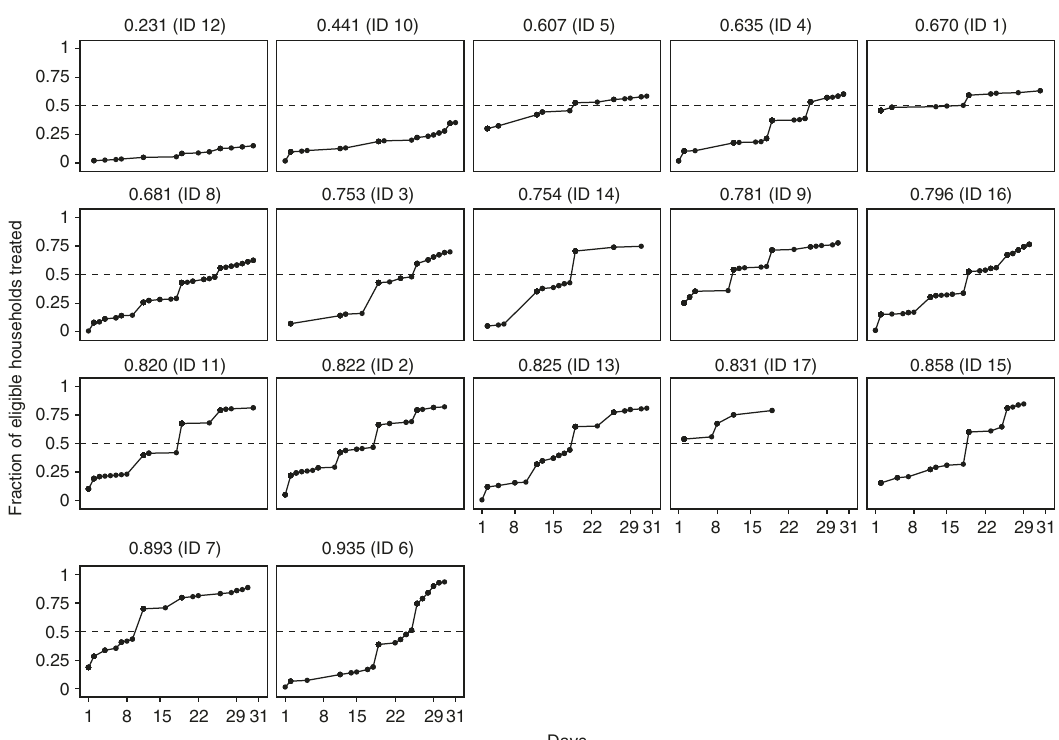
Fig. 3 Time series of household treatment coverage. In Fig. 3, household coverage is the cumulative fraction of eligible households where at least one eligible individual was offered at least one drug through mass drug administration. Information on the day of drug receipt was unavailable for individuals refusing treatment. These noncompliers were excluded from the calculation of treatment delivery speed (see Supplementary Methods). To enable a comparison with the reach of household coverage, the plots are ordered by household coverage achieved, which is stated in the graph titles. Household coverage may differ from the graph maximum. Household coverage included noncompliers and individuals who were offered and accepted treatment but did not remember the day of drug receipt. In parentheses, the village ID is presented. The dashed line represents 50% household treatment. Village ID 17, which had a shorter distribution span than the other villages, was the smallest village of only 65 households. This village also approached 50% of households in the fi rst day of distribution. As a robustness check, the speed analysis was repeated for individual coverage, which was the proportion of eligible individuals offered treatment (Supplementary Fig. 3 and Supplementary Table 8). In this case, village ID 17 approached 50% of eligible